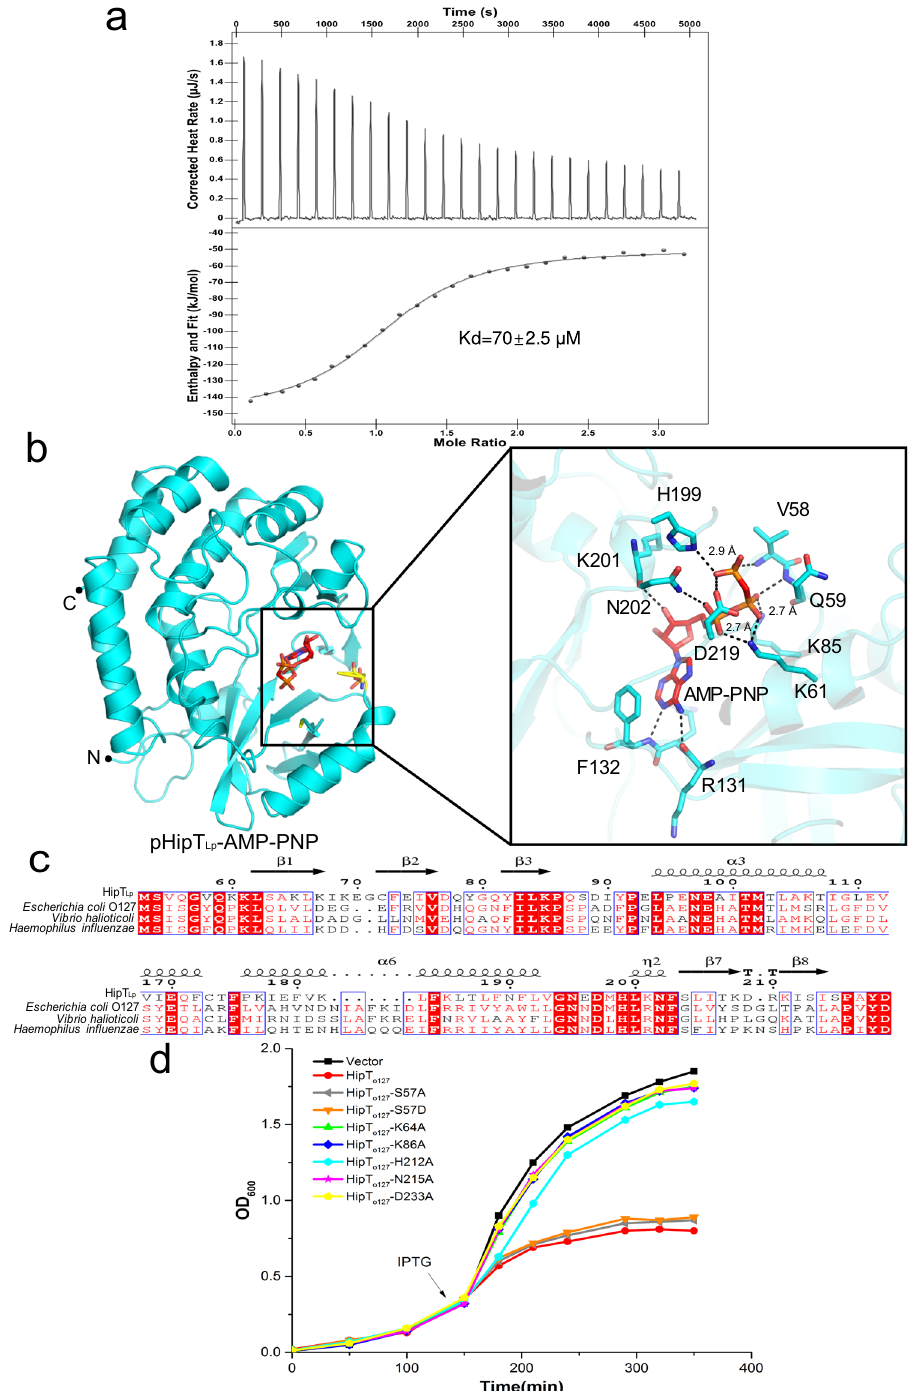
Fig. 4 | Crystal structure of the pHipT Lp – AMP – PNP complex. a Binding of AMP – PNP to pHipT Lp monitored by ITC, the presented data is from a single ITC experiment. b Left:cartoonrepresentationofthepHipT Lp – AMP – PNPcomplex.The